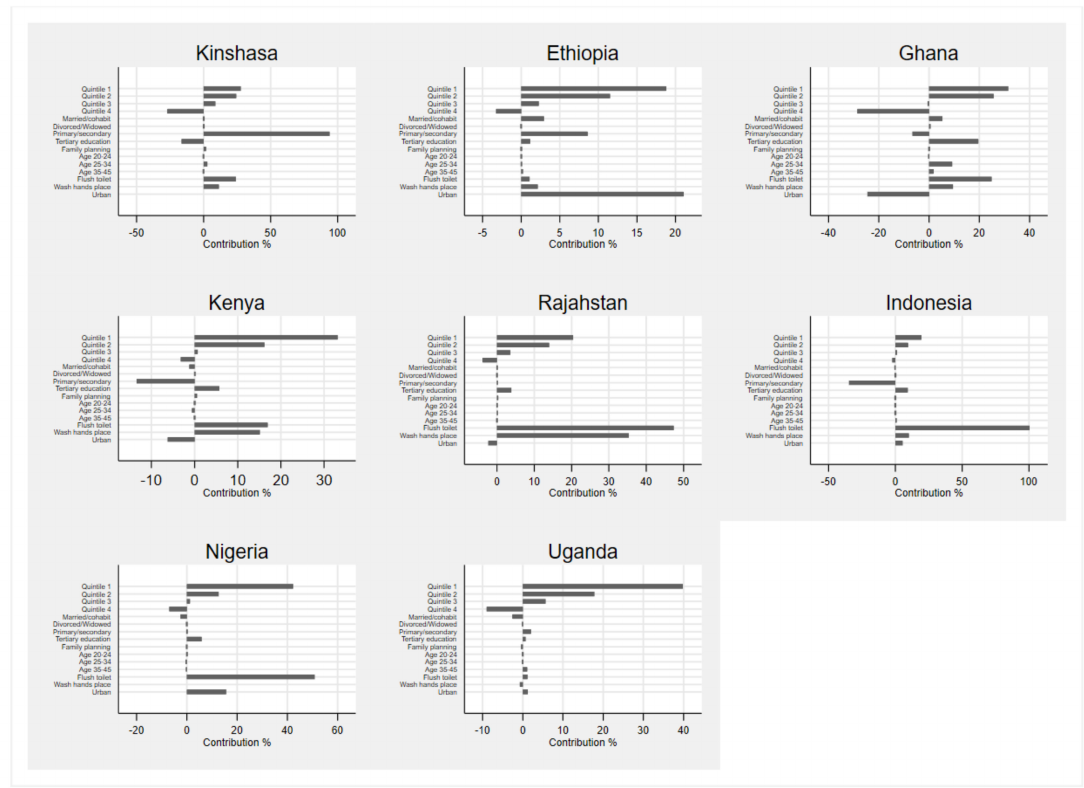
Figure 2. Contribution % of various factors to the CCIs of MHM